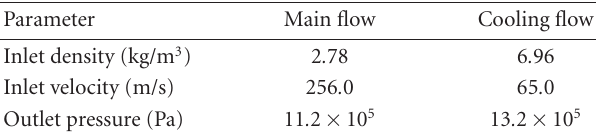
Table 2: Boundary conditions ( M = 2 .